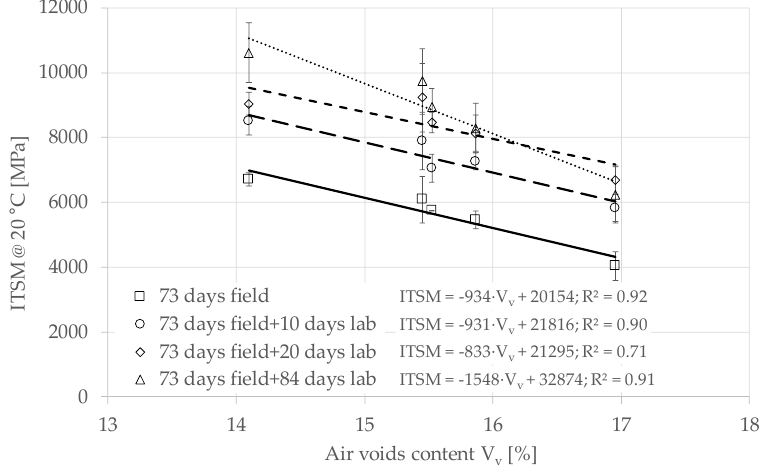
Figure 9. Relationship between indirect tensile stiffness modulus (ITSM) and air voids content of specimens of Group 2 at different curing times.